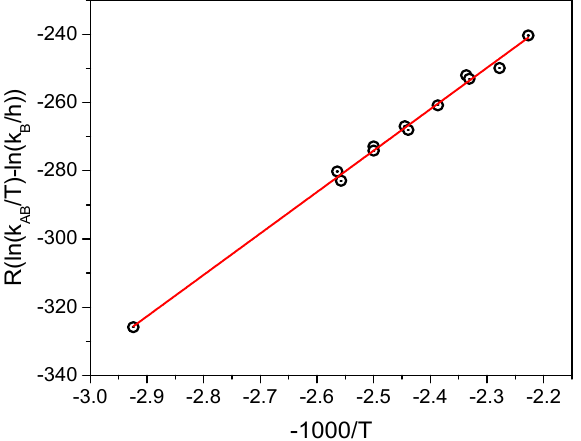
/ SR diastereomer.